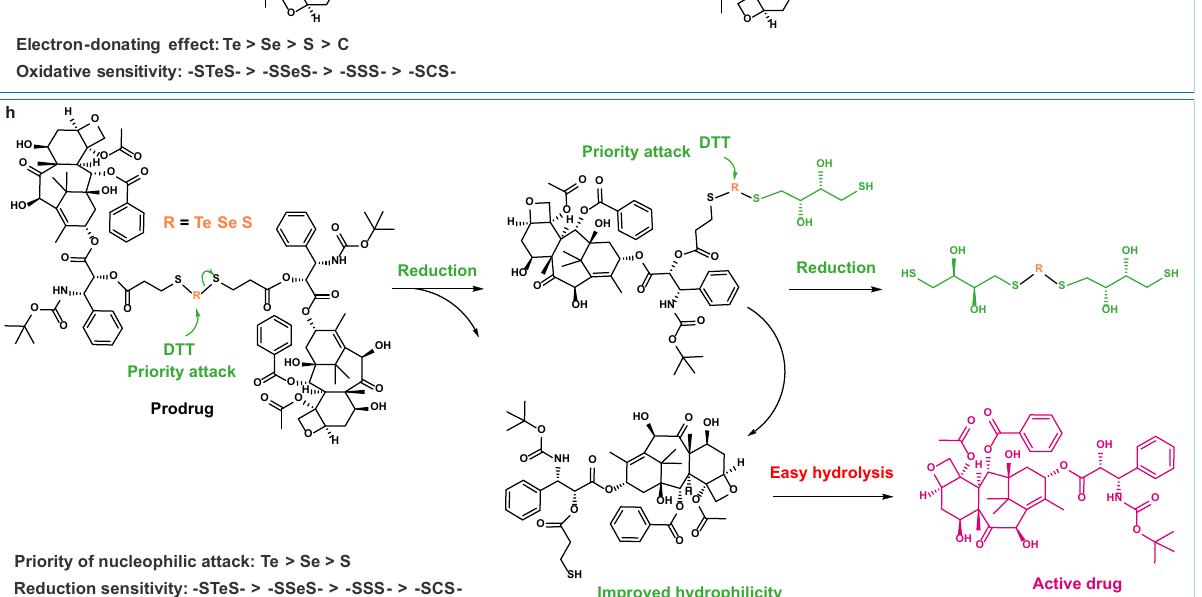
Source data are provided as a Source Data fi le. Mechanisms of the oxidation- responsiveness ( d ) and reduction-responsiveness ( h ) of